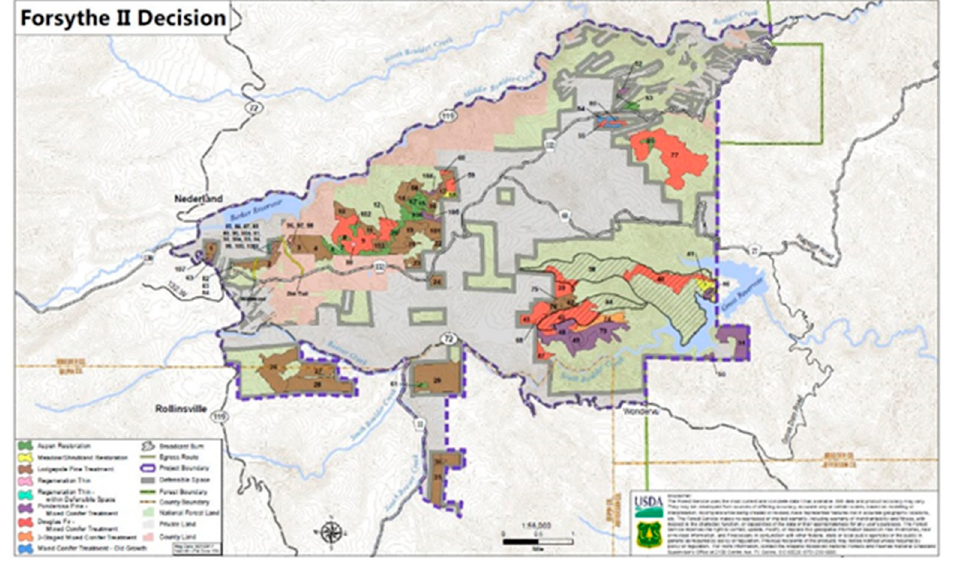
Figure 1. Forsythe II Decision.